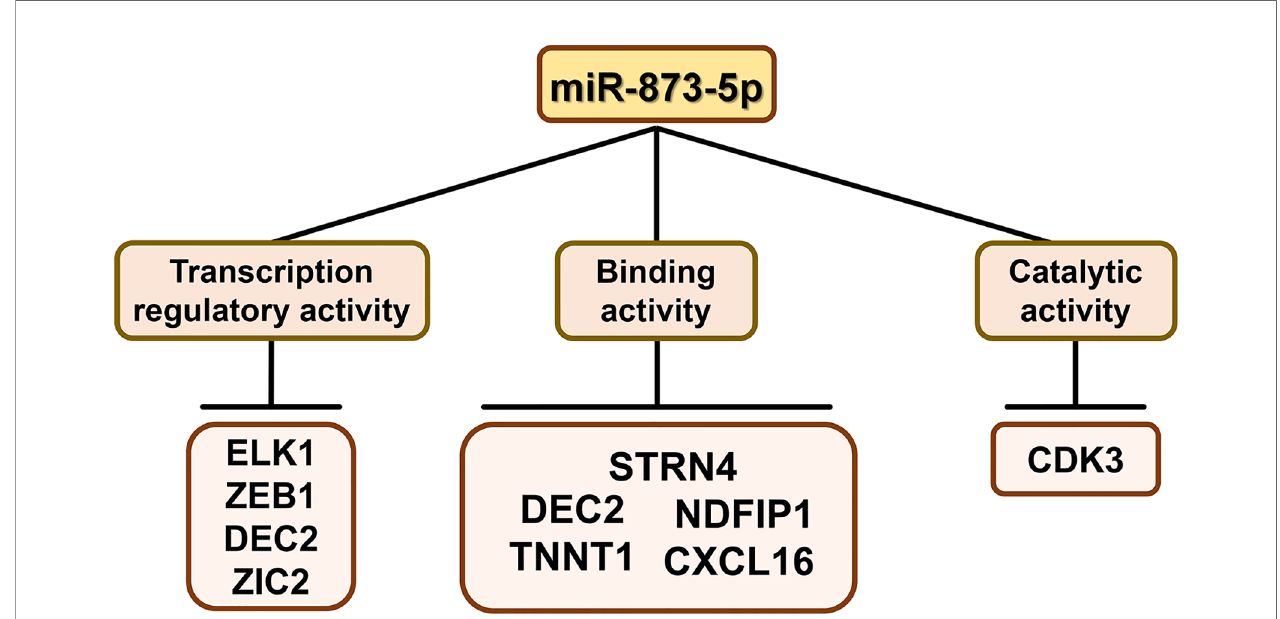
FIGURE 2 | The molecular functions of miR-873-5p target genesThe target genes of miR-873-5p have the molecular functions of binding, catalytic, and transcription regulator